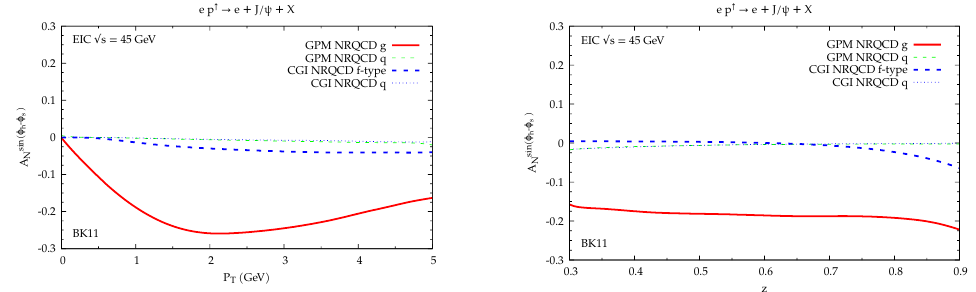
Figure 2: Maximized Sivers asymmetry for the ep ↑ → e + J /ψ + X process as a function of P (left panel) and z (right panel) obtained with the BK11 LDME set [ 18 ] (cid:112) T s = 45 GeV: GSF contribution in NRQCD for GPM (red solid thick line), CGI-GPM at (blue dashed thick line), quark Sivers contribution in NRQCD for GPM (green dashed thin line) and CGI-GPM (blue dotted thin